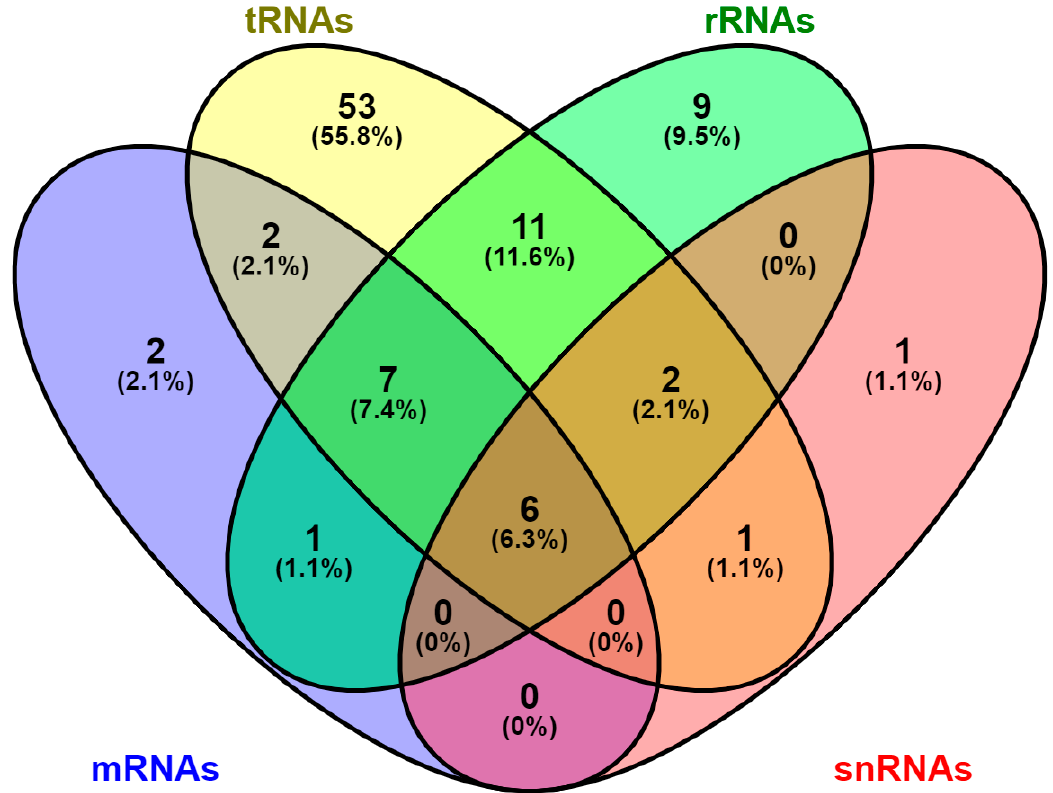
Figure 1. Venn diagram demonstrating the number of common RNA modifications that exist among many classes of RNA molecules, including tRNAs, mRNAs, and rRNAs, as well as snRNAs. RNA modifications are implicated in the regulation of several facets of RNA pro- cessing, thus possessing an indispensable role for the generation of functional RNA mol- ecules [7,8]. These changes can be added or removed by different types of enzymes that